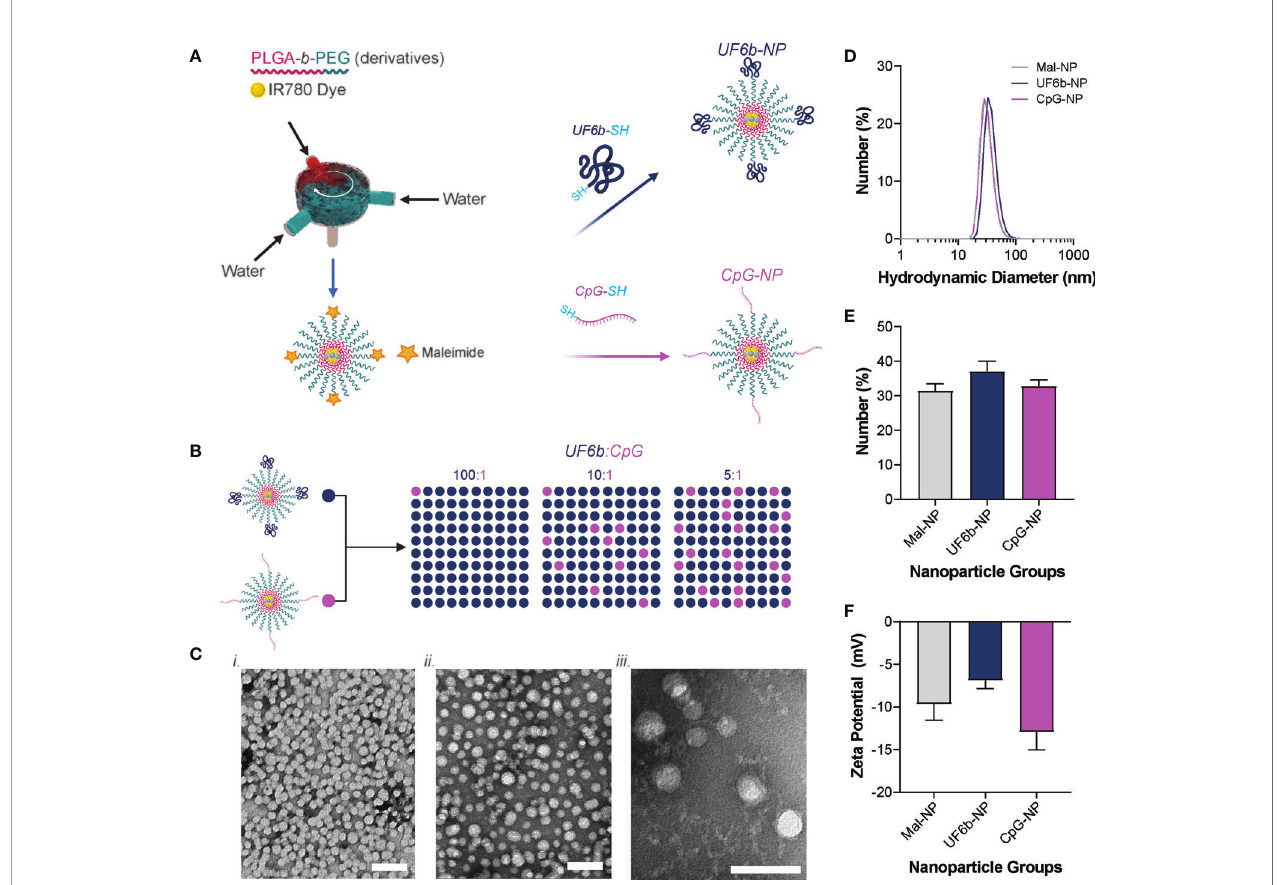
FIGURE 1 | Nanoparticle conjugation scheme. (A) PEG- b -PLGA NPs were produced by fl ash nanoprecipitation (FNP) and then conjugated with thiolated UF6b or CpG oligodeoxynucleotide containing immunostimulatory sequence (ODN ISS) 1018. (B) The UF6b-NP and CpG-NP were then mixed together in different mass ratios to yield the NPs used for the vaccination study. (C) Transmission Electron Microscopy of the Mal-NP, UF6b-NP, and CpG-NPs. Scale bars = 50 nm. (D) Size distribution of each NP population, (E) the mean number-weighted hydrodynamic diameter of each NP population, and (F) zeta potential of each NP population measured in 10 mM NaCl and 10 mM HEPES (pH 7.4). Error bars indicate standard deviation of four